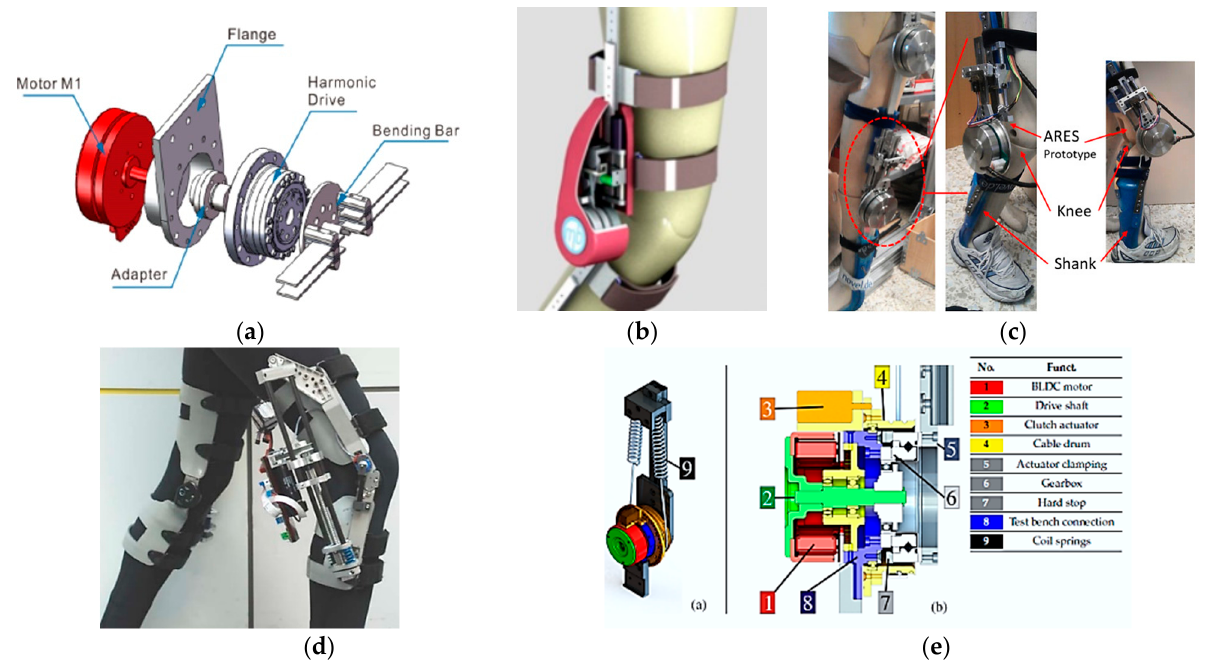
Figure 8. Knee orthoses: ( a ) Liu et al., 2015 [24], ( b ) García et al., 2015 [50], ( c ) Cestari et al., 2015 [51], ( d ) Dollar et al., 2008 [43], ( e ) Penzlin et al., 2019 [48].